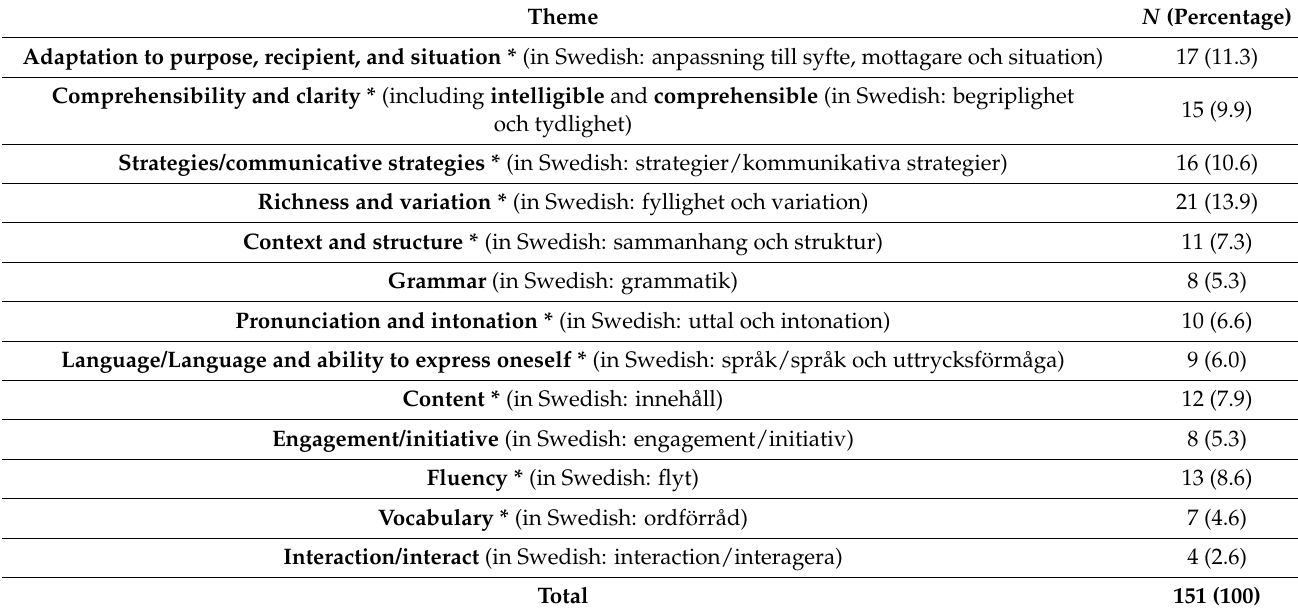
Table 4. Themes STs Y9—Number of times mentioned in categories CRITERION and ASPECT .